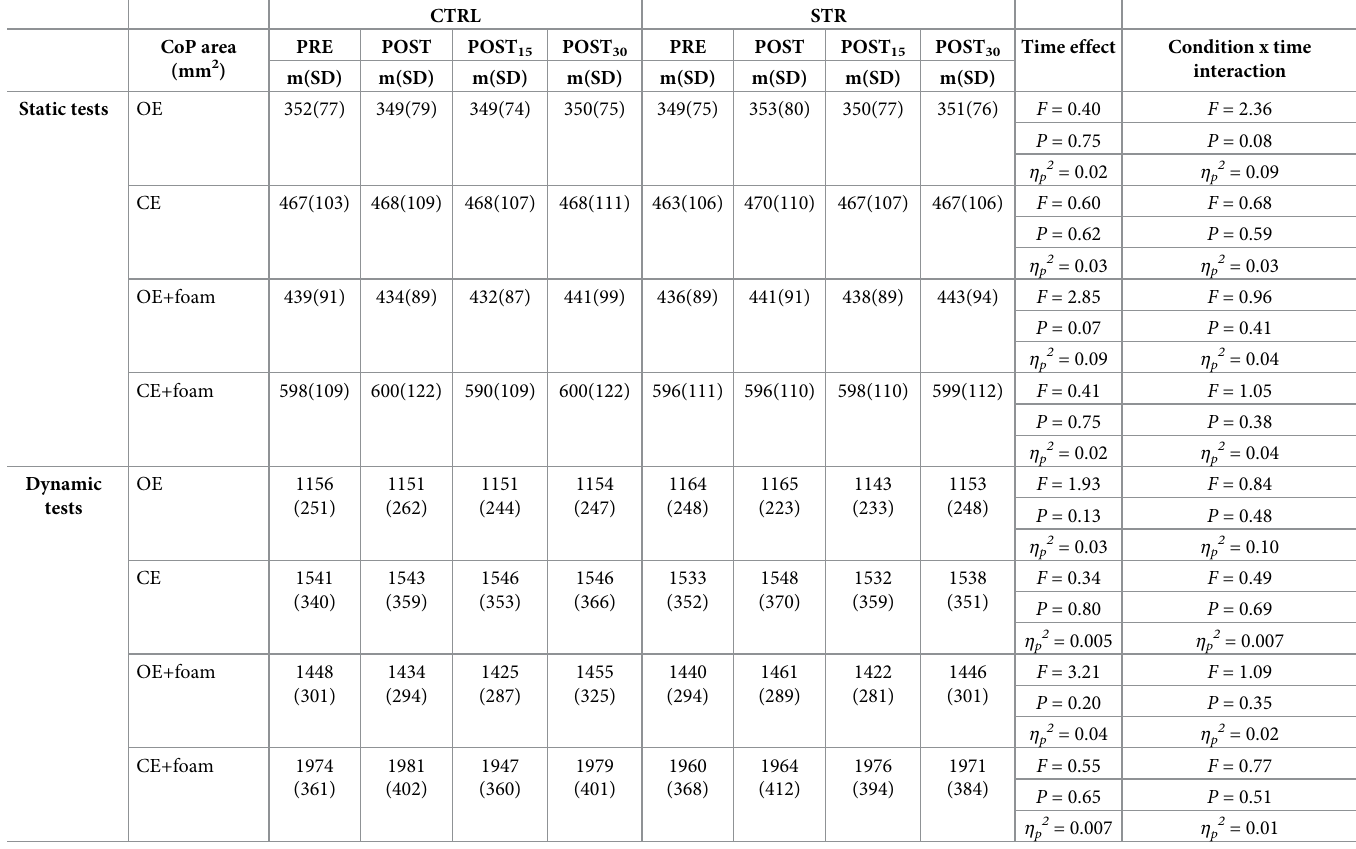
Table 3. Time course of centre of pressure (CoP) area in the control (CTRL) and stretching session (STR) during the static and dynamic tests. CTRL STR CoP area (mm 2 )